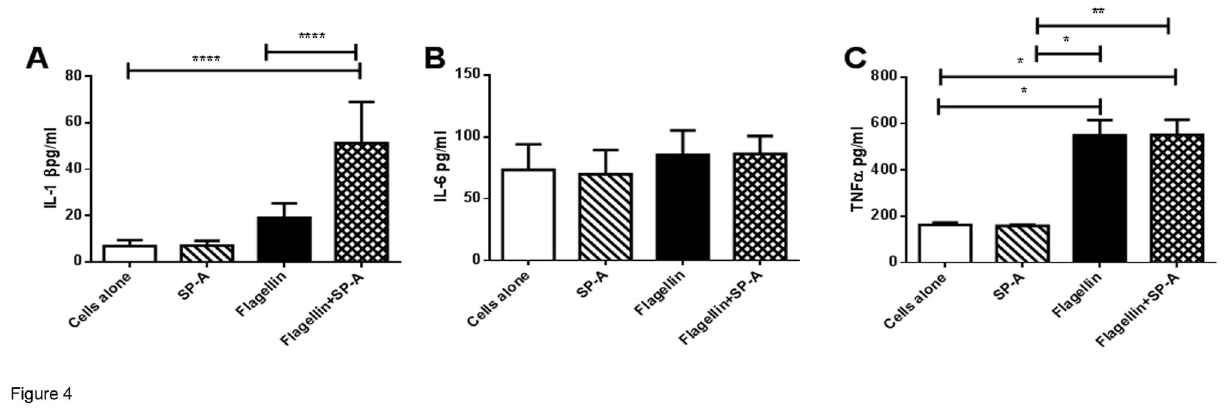
Figure 4. SP-A Enhanced Flagellin Stimulated IL-1β Production. Concentrations of IL-1β, IL-6 and TNF-α, were assessed in the media of MH-s cells following stimulation with SP-A alone, flagellin or flagellin with SP-A. IL-1β, but not IL-6 or TNF-α, production was enhanced by flagella with SP-A after the 60min stimulation. Data is expressed as pg/ml and represent mean ±SEM, with n=6-10 separate samples/group. *p<0.05, *p<0.01, ****p<0.0001 when analyzed by Kuskal-Walis ANOVA followed by Dunn’s multiple comparison test. doi: